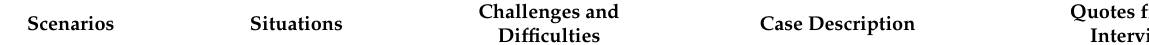
Table 3. Profiles of 9 cases from top 3 official media in China (February 2020–February